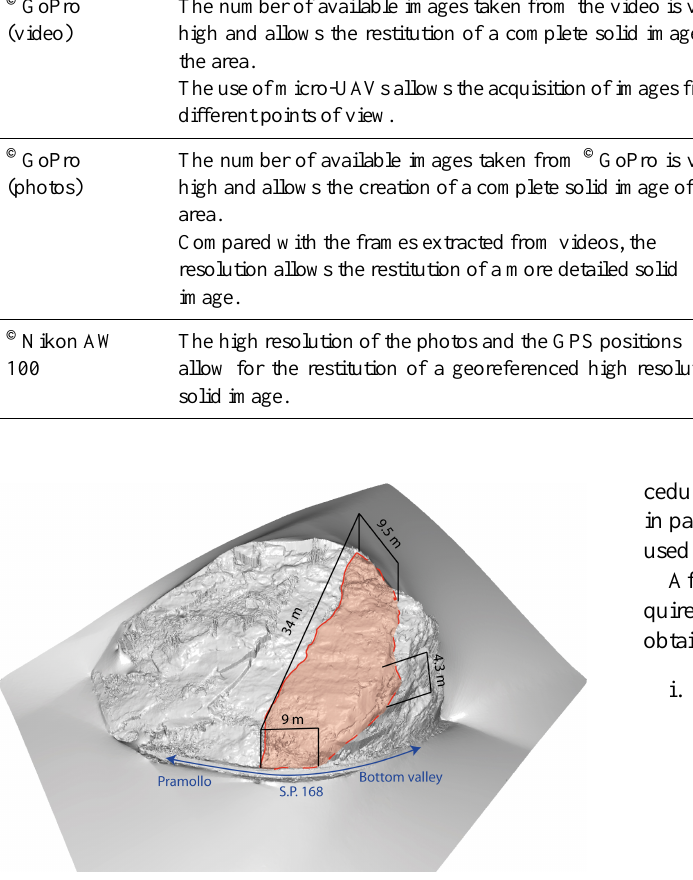
Figure 2. Shaded relief of the studied area with the indication of the dimension of the unstable sector (red area). The DSM of the unstable area before the rockfall event derived from the © GoPro data set allows us to define the orientation of the main discontinu- ities: the principal shear plane has an orientation of 178 / 45 (dip direction/dip) and the lateral one of 325 / 81 (dip direction/dip). The maximum opening of the main fracture (continuous line on the pic- ture) is 83cm. These results have been obtained in ca. 3h processing time with © Agisoft Photoscan, by considering an AMD Phenom X4 955 CPU (3.2GHz), 10GB